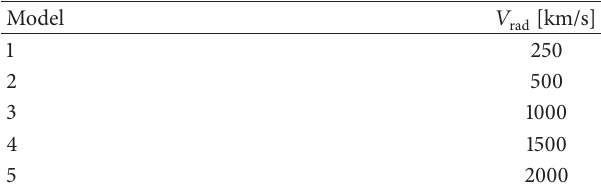
Table 1: Wind models for the first and second scenarios. Table 2: Wind models for the third